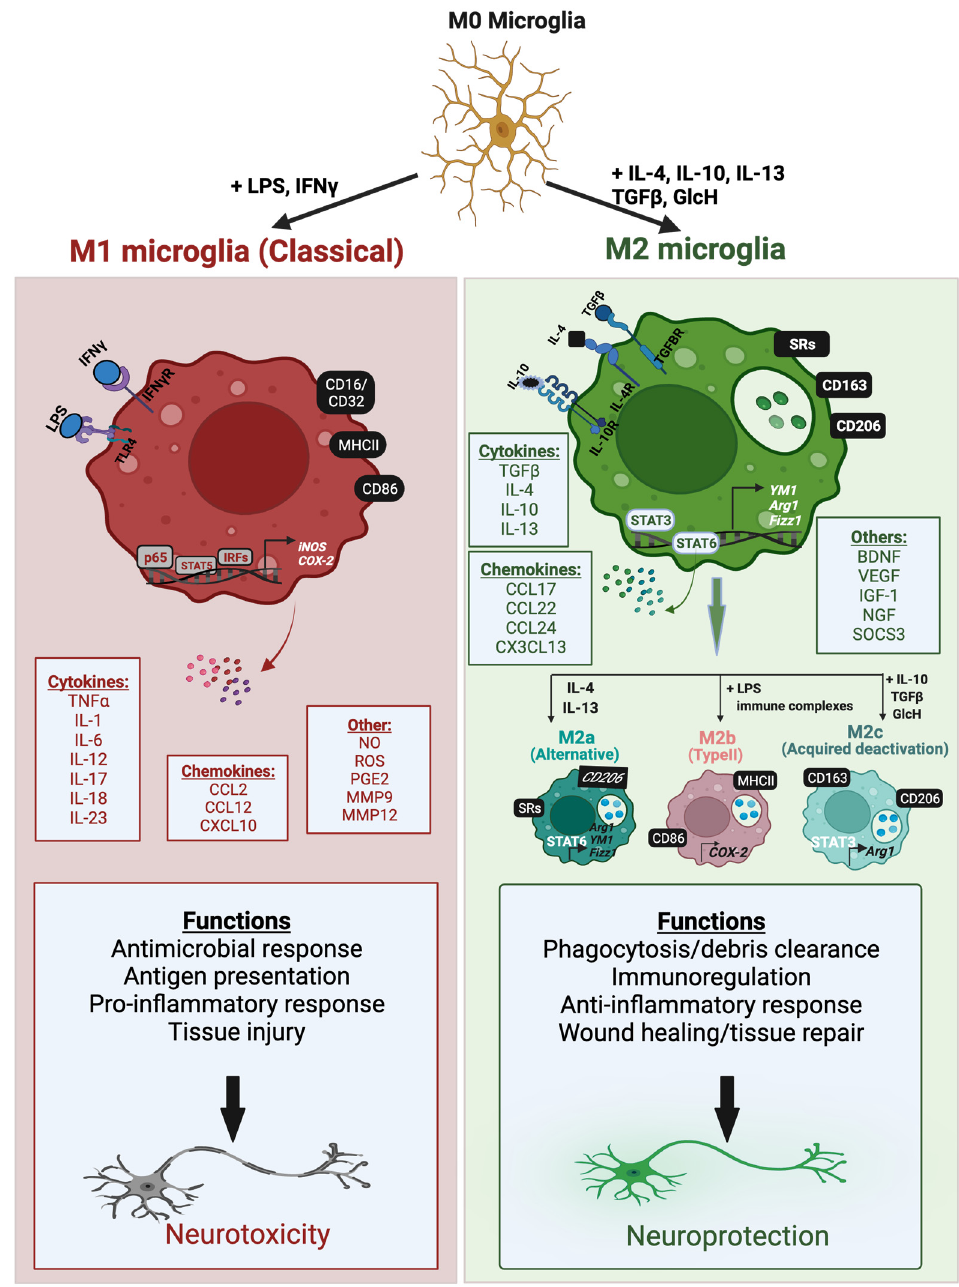
Figure 1. Microglial activation phenotypes and functions. Microglia can be polarized from a resting state (M0 microglia) to two main activation phenotypes, classically activated M1 microglia and alternatively activated M2 microglia, which are induced by interaction of inflammatory molecules with their respective cognate receptors. These microglia phenotypes exhibit a variety of phenotypic markers that are expressed intracellularly or on the cell surface, as well as molecules that are secreted from the cell, such as chemokines, cytokines, and other effector molecules. The M2 phenotype is further subdivided into three subtypes: M2a (alternatively activated state), M2b (type II activation phenotype), and M2c (acquired deactivation state). The M2b subtype shares similar features as M1 microglia and is induced by inflammatory molecules. The phenotypes of M1 and M2 microglia perform distinct functions that can be neurotoxic or neuroprotective, respectively. Figure created using BioRender.com (accessed on 14 April 2022).